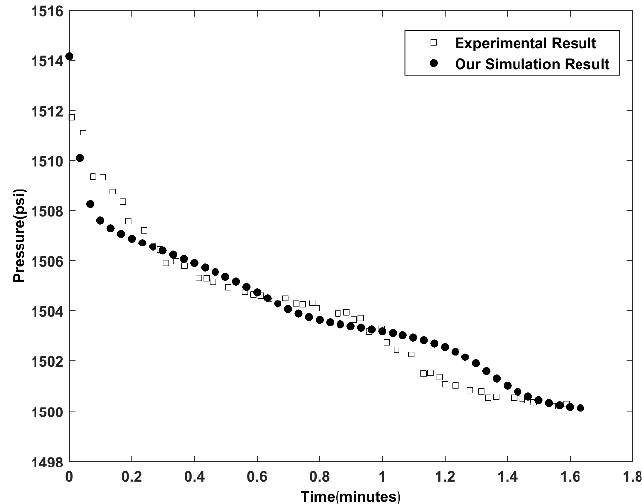
Figure 3. Comparison of pressure at the inlet during acid injection.